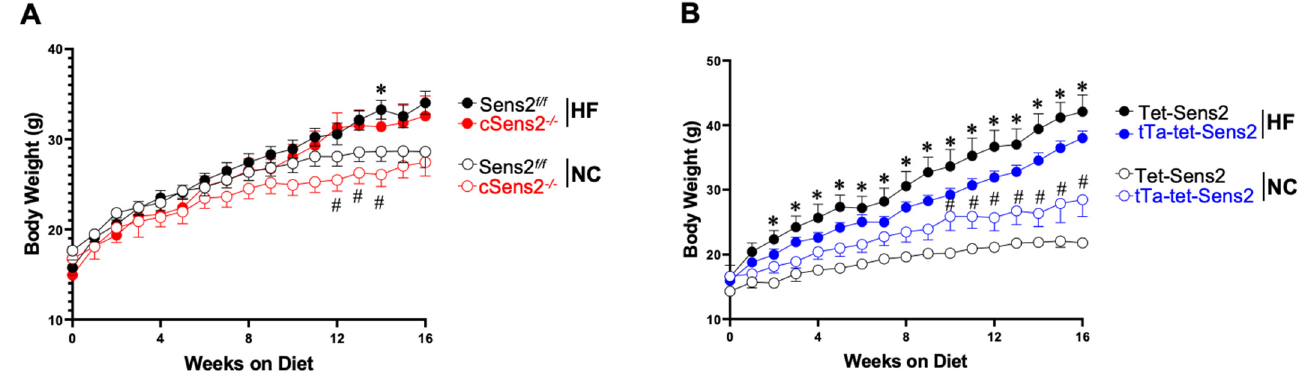
Figure 2. Body weight over time. Body weights were measured weekly until mice reached 16 weeks of dietary intervention. ( A ) Comparison of body weights over 16 weeks for Sesn2 flox / flox and cSesn2 − / − mice on NC and HF diets. * p < 0.05 vs. Sesn2 flox / flox NC; # p < 0.05 vs. cSesn2 − / − HF. ( B ) Comparison of body weights over 16 weeks for tet-Sesn2 and tTa-tet-Sesn2 mice on NC and HF diets. * p < 0.05 vs. tet-Sesn2 NC; # p < 0.05 vs. tTa-tet-Sesn2 HF. Data are means ± SE.